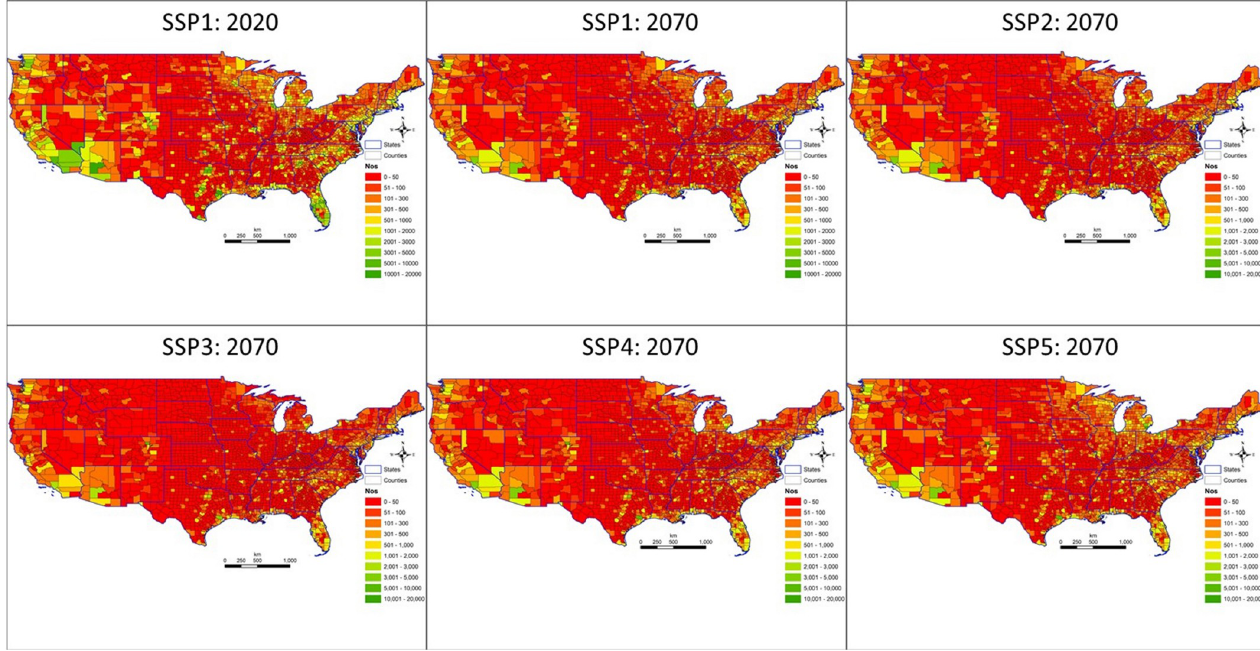
Fig 3. Projected housing starts by county in 2020 under Shared Socioeconomic Pathway (SSP) 2 (upper left) and in 2070 for SSP1-5 (upper- mid to lower right). Figure was created by the authors in ESRI’s ArcGIS 10.5 software (https://www.esri.com). The USDA-NRCS topo (https://gdg.sc.egov.usda.gov/ GDGHome.aspx) was used as a basemap (NRCS Counties by State, and NRCS States by State) in this figure.